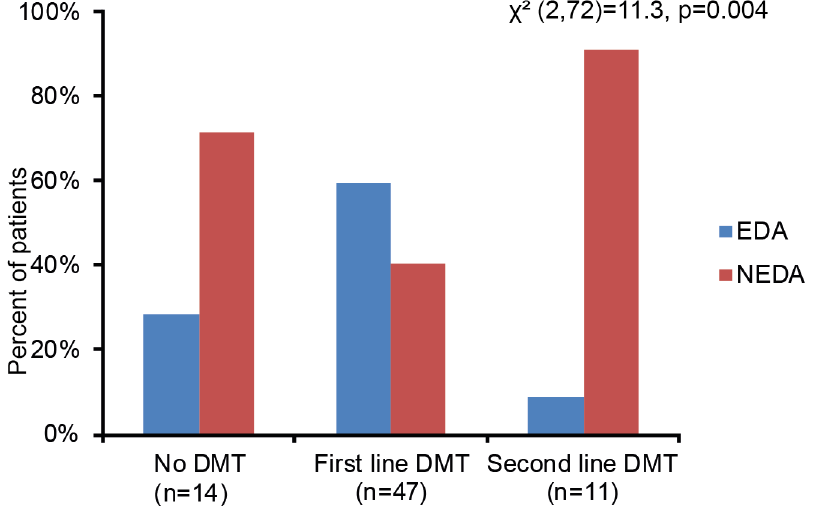
Fig 4. Disease activity in different treatment groups. Treatment groups as baseline of patients with EDA or NEDA one year